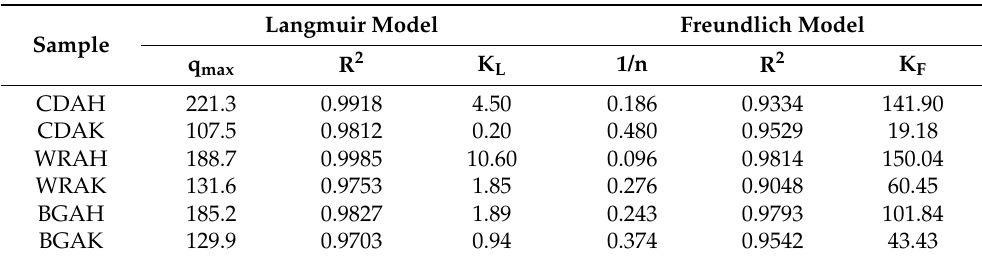
Table 5. Langmuir and Freundlich parameters of the isotherms of methylene blue adsorption on the activated carbons prepared from waste food products.